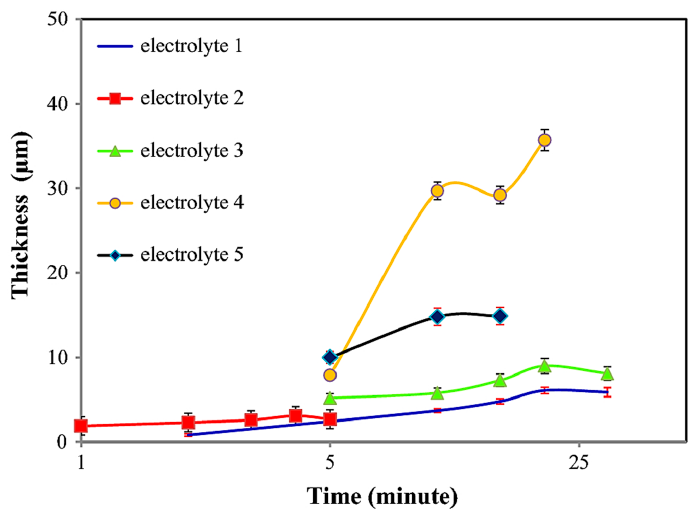
Figure 6. Comparison of coating thickness obtained from electrolytes versus time. Reproduced with permission from [101]. Copyright Springer Nature, 2019.